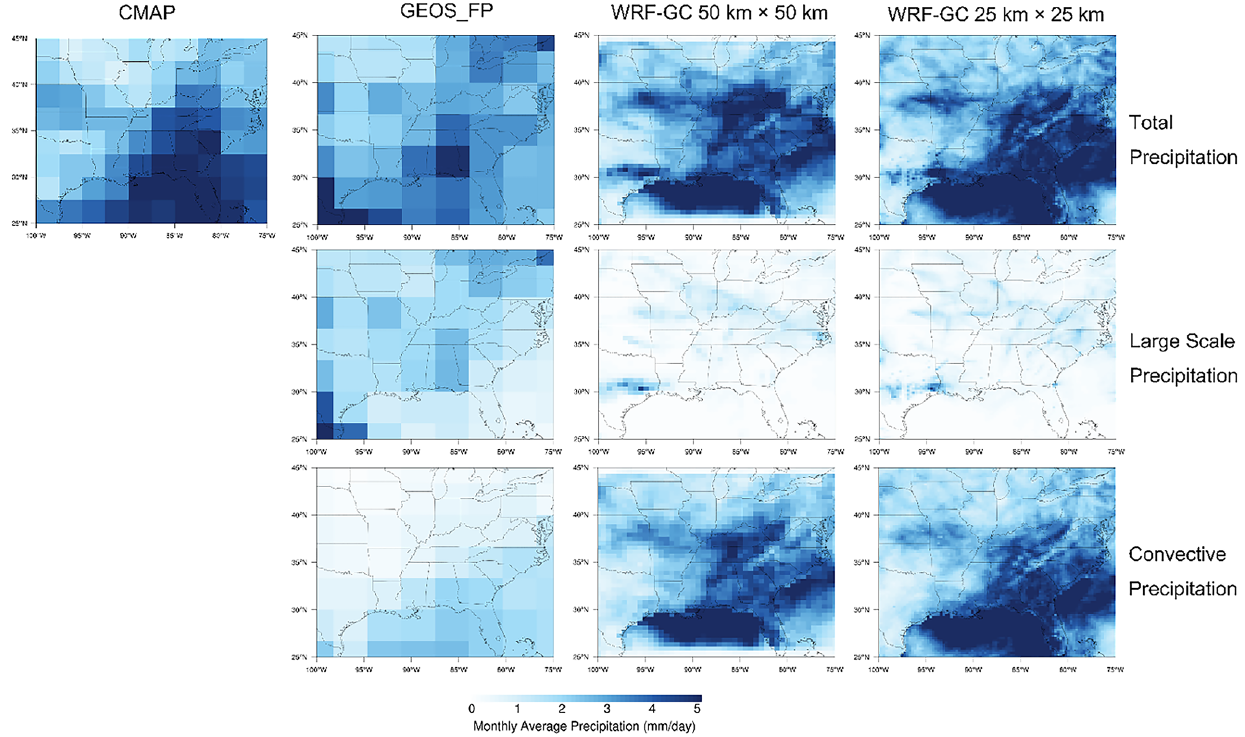
Figure 3. Monthly average precipitation from July to September 2013. Left top corner: CPC Merged Analysis of Precipitation; second to fourth column: GEOS_FP offline meteorological dataset and WRF-GC precipitation at 50km × 50km and 25km × 25km resolution; from top to bottom: 3-month average precipitation, non-convective precipitation, convective